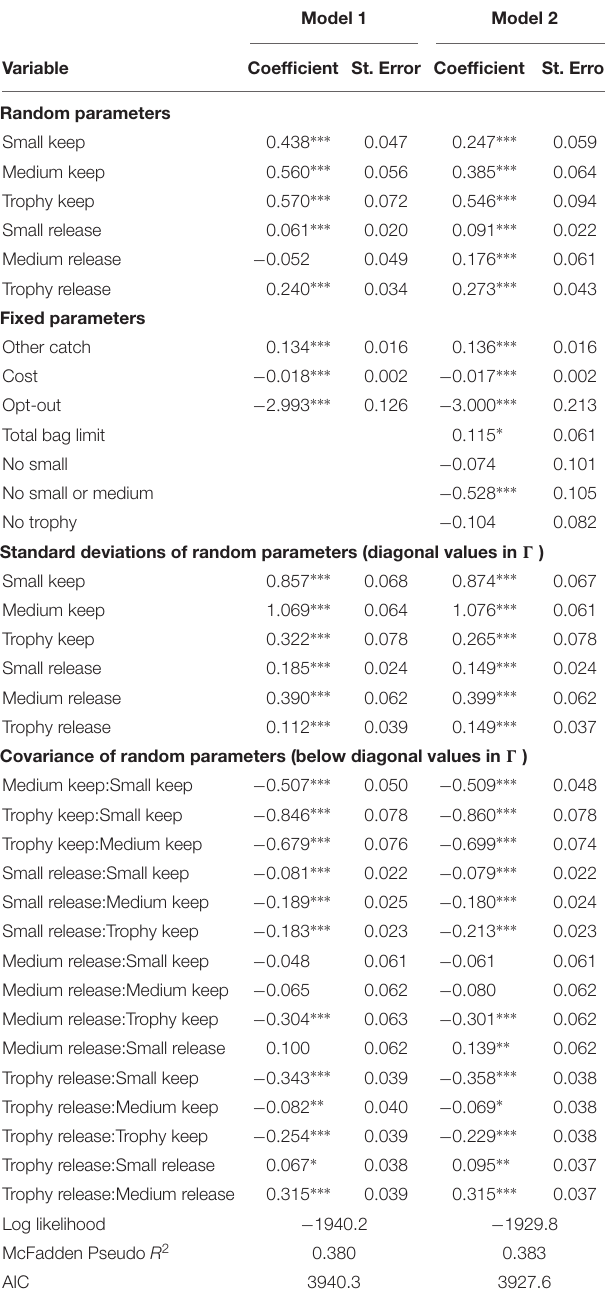
TABLE 4 | Utility parameter estimates from panel rank-ordered mixed logit model. Model 1 Model